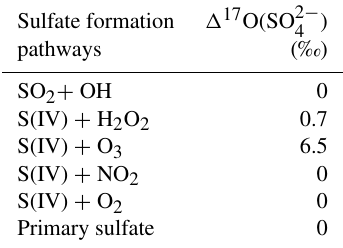
Table 1. Sulfate isotope